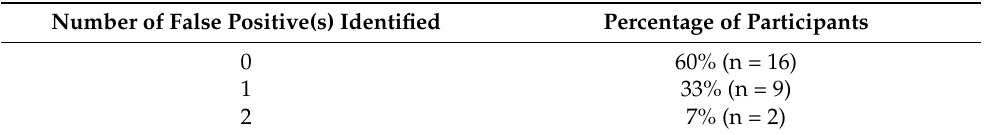
Table 4. Frequency of false positive